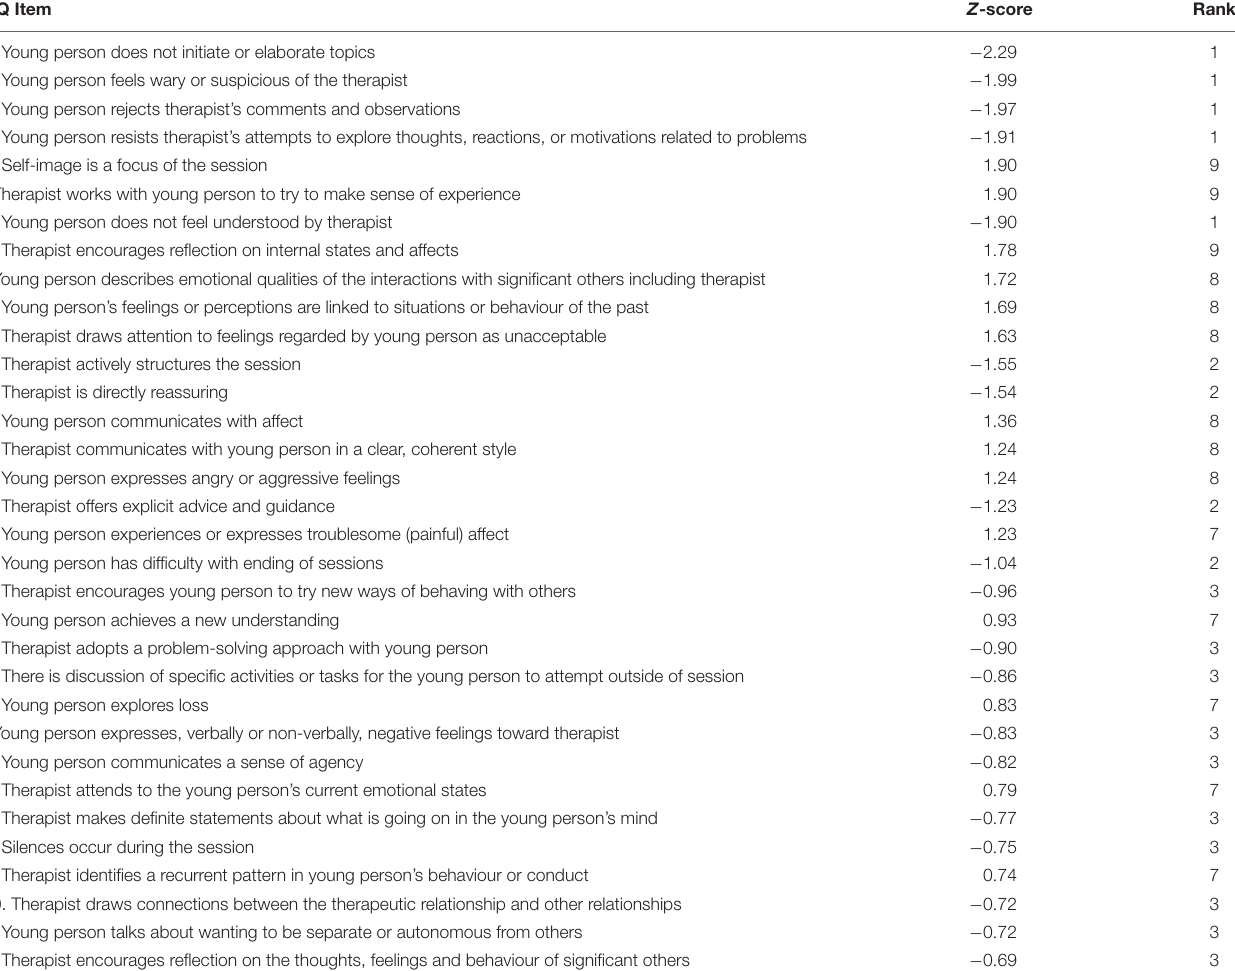
TABLE 3 | Interaction structure 1: “Mutual trust, collaboration and the exploration of emotions.” APQ Item Z -score